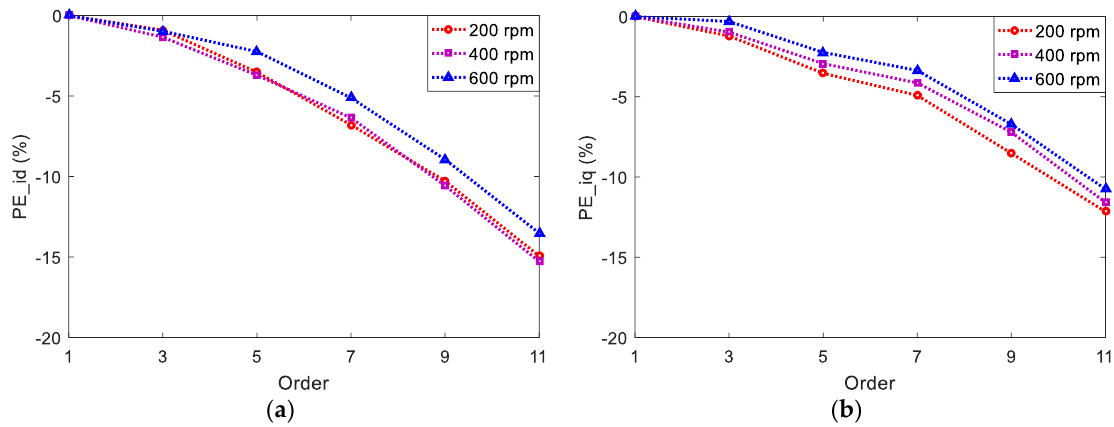
Figure 3. Relative prediction error under different discretization orders. ( a ) Relative prediction error of i d ; ( b ) Relative prediction error of i q .